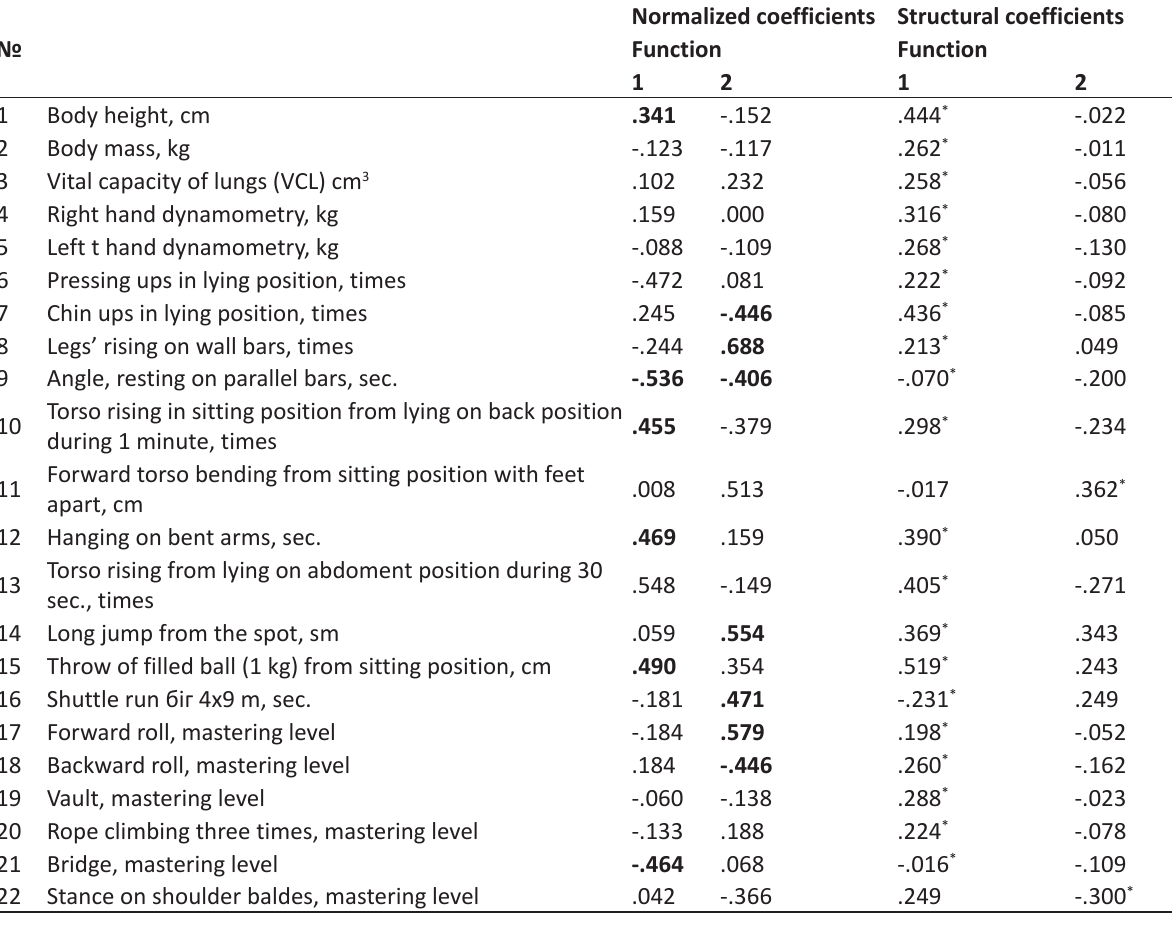
Table 3. Coefficients of canonic discriminant function